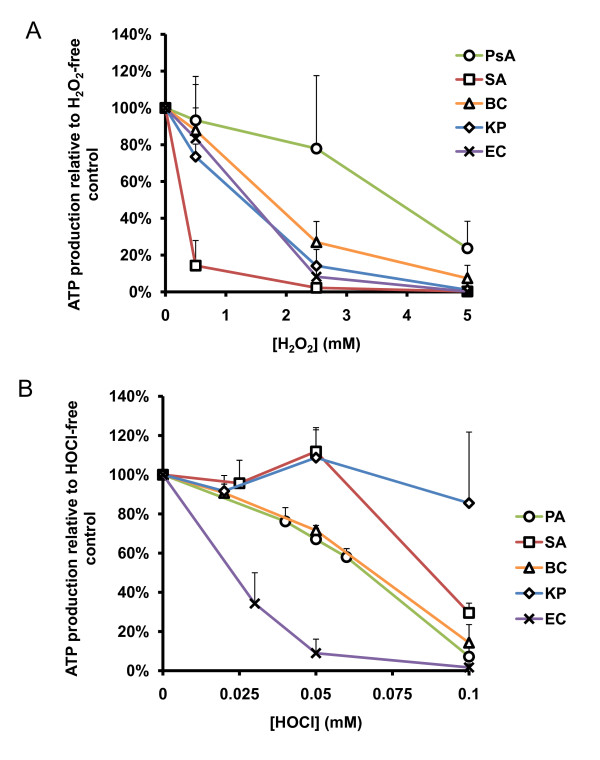
H2O2- and HOCl-induced ATP changes in bacterial pathogens. Bacteria were exposed to reagent H2O2 or HOCl, in vitro, to determine the effect of the oxidant on ATP production as measured by the BacTiter-Glo Microbial Cell Viability Assay (Promega). Concentrations of oxidants used were based on the amounts necessary to eradicate CFU viability as assessed in the previous experiments. A) All organisms displayed significant reduction in ATP production (One-way ANOVA) in an H2O2 dose-dependent manner up to 5 mM. B) ATP production by KP was statistically unaffected by HOCl exposure up to 0.1 mM according to one-way ANOVA (p = 0.53) while all other organisms tested displayed significant HOCl dose-dependent reduction in ATP production in this concentration range. Error bars represent standard deviation of at least n = 3 experiments.